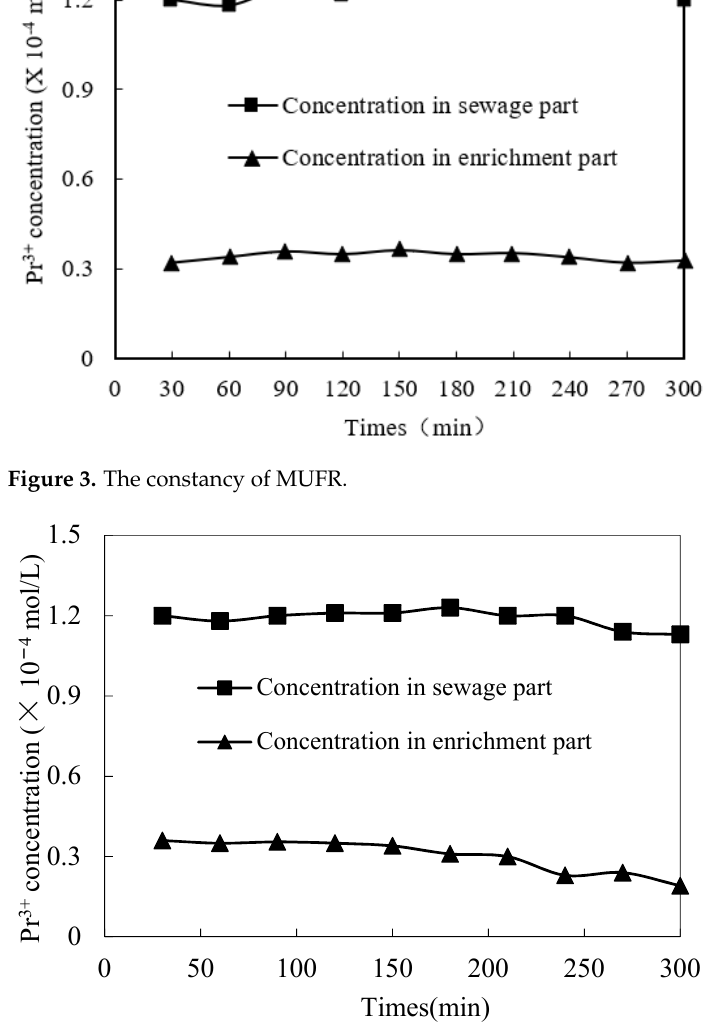
Figure 4. The constancy of conventional SLM.